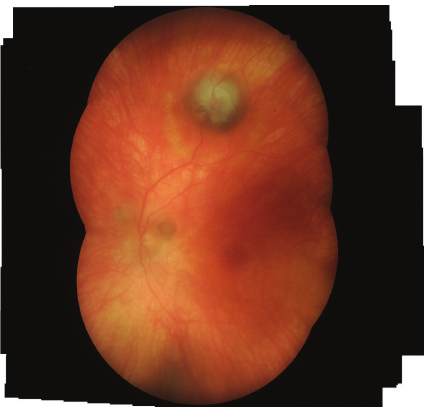
Figure 1: (A-B) Fundus examination of LE showed features of chronic recurrent Vogt-Koyanagi-Harada disease, including “sunset glow fundus,” hyperpigmented striae, and multiple atrophic chorioretinal spots in the periphery (not shown); darkly pigmented exuberant subretinal mass extended to the periphery with associated subretinal fibrosis. There were 2 smaller pigmented subretinal lesions located around the optic disc.